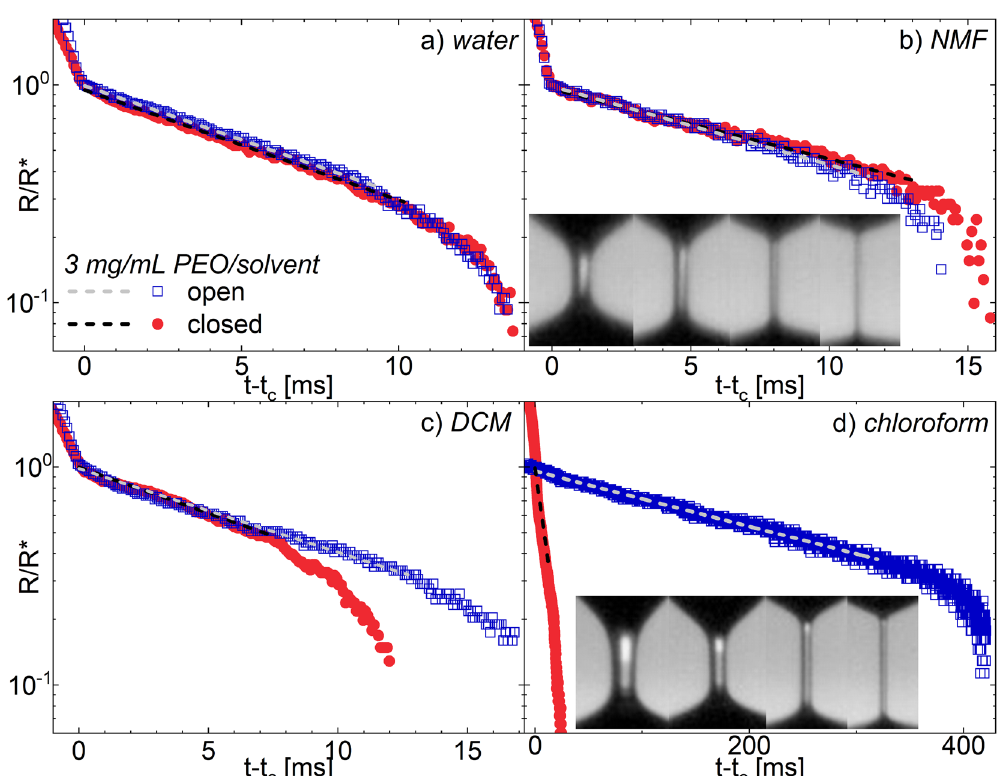
Figure 2. Representative evaporation-controlled DoS capillary thinning measurements of 3 mg/mL PEO in: ( a ) water, ( b ) NMF, ( c ) DCM, and ( d ) chloroform. Insets in ( b ) and ( d ) show 2D images of the thinning inside of the chamber at (from L to R) R / R ∗ = 1 (onset of EC regime), 0.7, 0.4 and 0.1. ( a , b ) As expected, no statistically significant difference in (cid:31) E is observed for low volatility solvents (water, NMF); see Table 1. ( c , d ) In more volatile solvents (chloroform, DCM), pronounced differences in the thinning profiles and (cid:31) E result between trials taken inside versus outside the environmental control